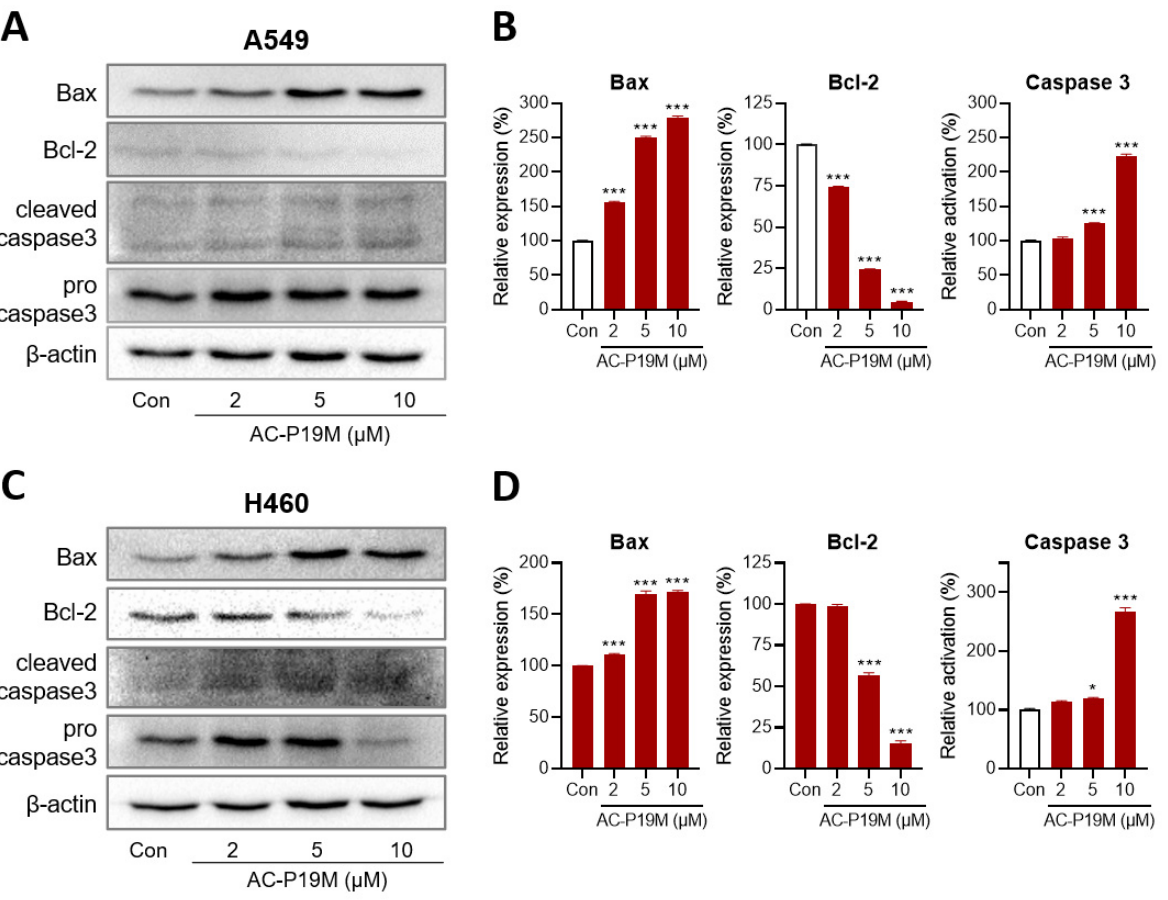
Figure 4. Effect of AC-P19M on the expression of apoptosis markers in lung cancer cells. Western blot analysis was conducted to measure the protein levels of apoptosis markers, Bax, Bcl-2, and caspase 3. AC-P19M treatment was performed on ( A , B ) A549 and ( C , D ) H460 cells for 24 h. Quantitative analysis of the western blot showed that the protein levels of Bax and caspase 3 increased, while those of Bcl-2 decreased in a dose-dependent manner after AC-P19M treatment. Data are presented as the mean ± SEM. *, p < 0.05; ***, p < 0.001 compared to the control group.